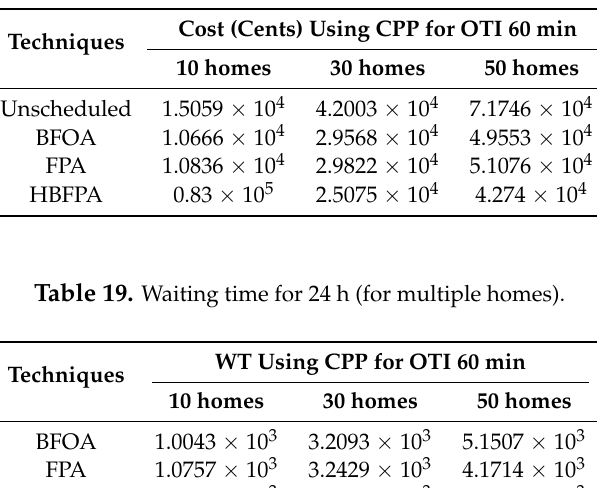
Figure 13. Electricity cost, waiting time and peak to average ratio for multiple homes: (10, 30 and 50) using critical peak pricing. ( a ) Electricity cost using operational time interval of 60 min; ( b ) Waiting time using operational time interval of 60 min; ( c ) Peak to average ratio using operational time interval of 60 min. Table 18. Electricity cost for 24 h (for multiple homes).